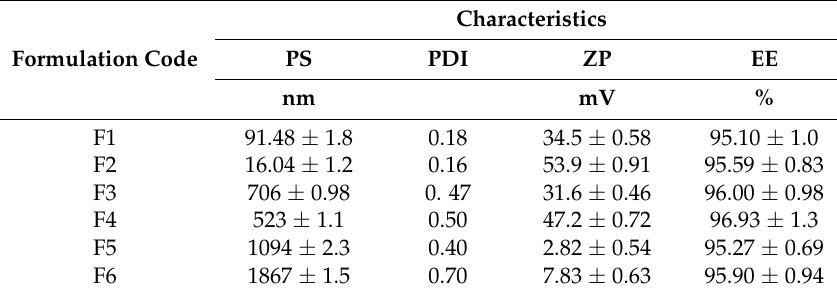
Table 2. Characteristics of leciplex formulae, n =